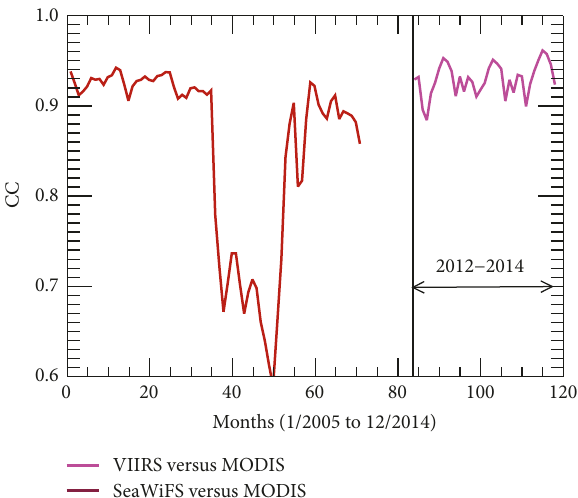
Figure 3: RMS differences: MODIS versus VIIRS and MODIS versus